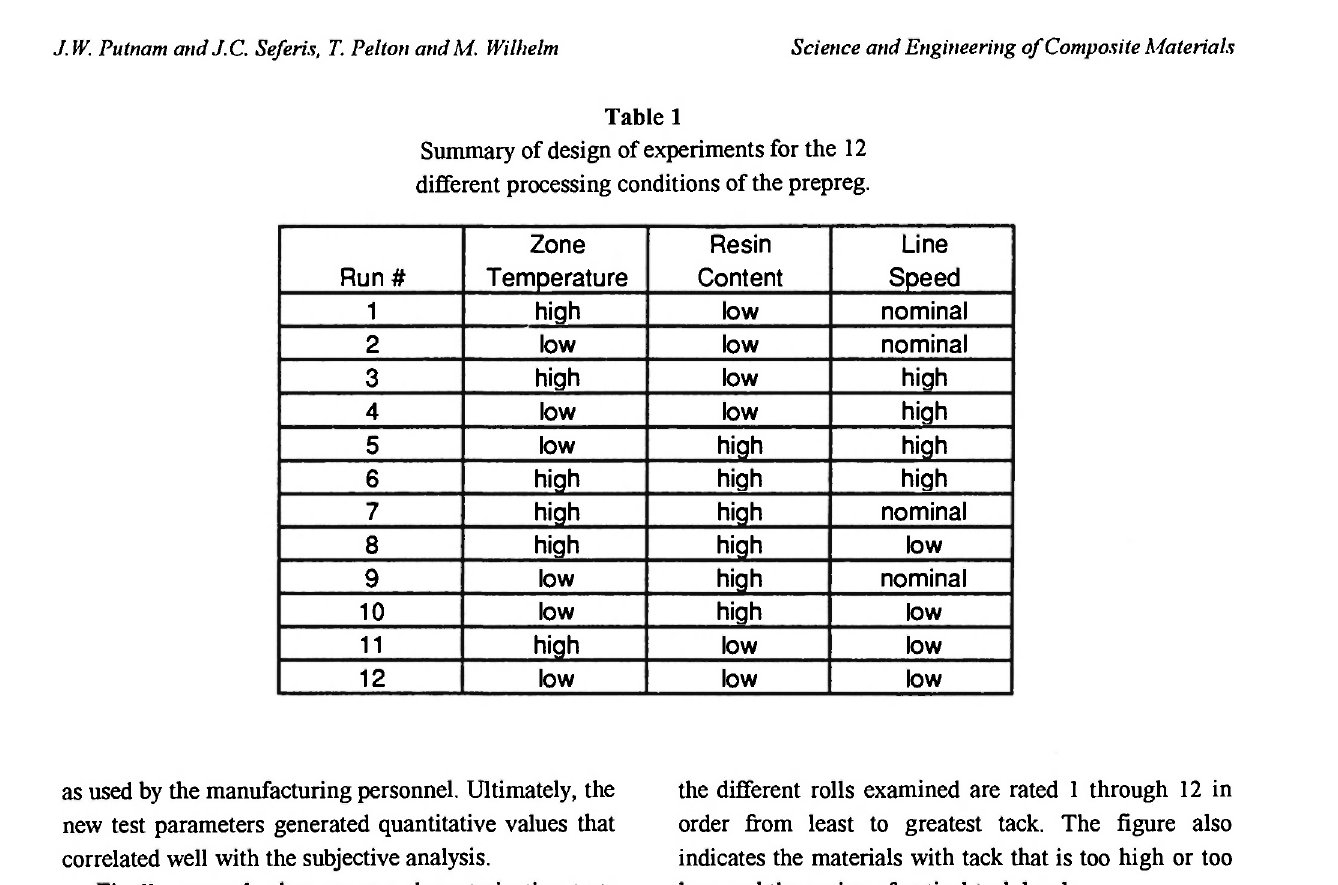
Summary of design of experiments for the 12 different processing conditions of the